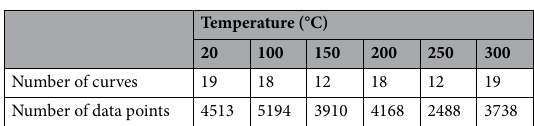
Table 1. Number of the stress–strain curves for each lot and each